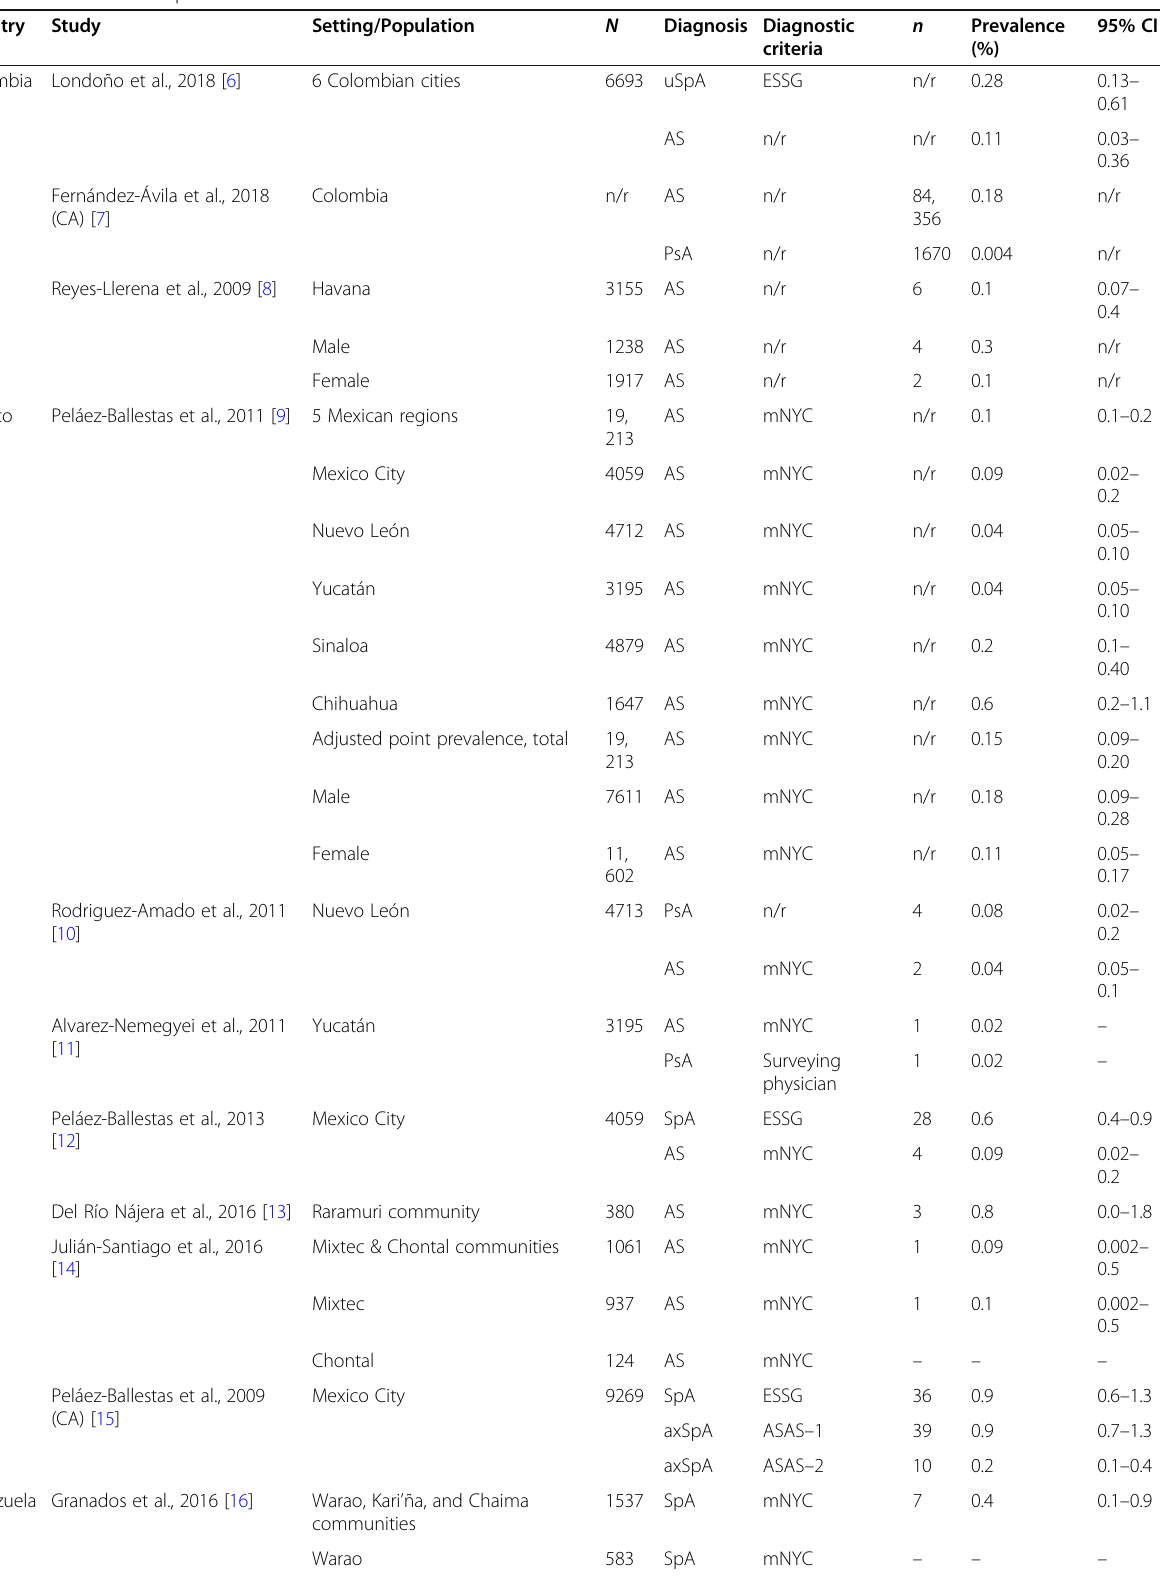
Table 1 Prevalence of SpA in Latin American countries